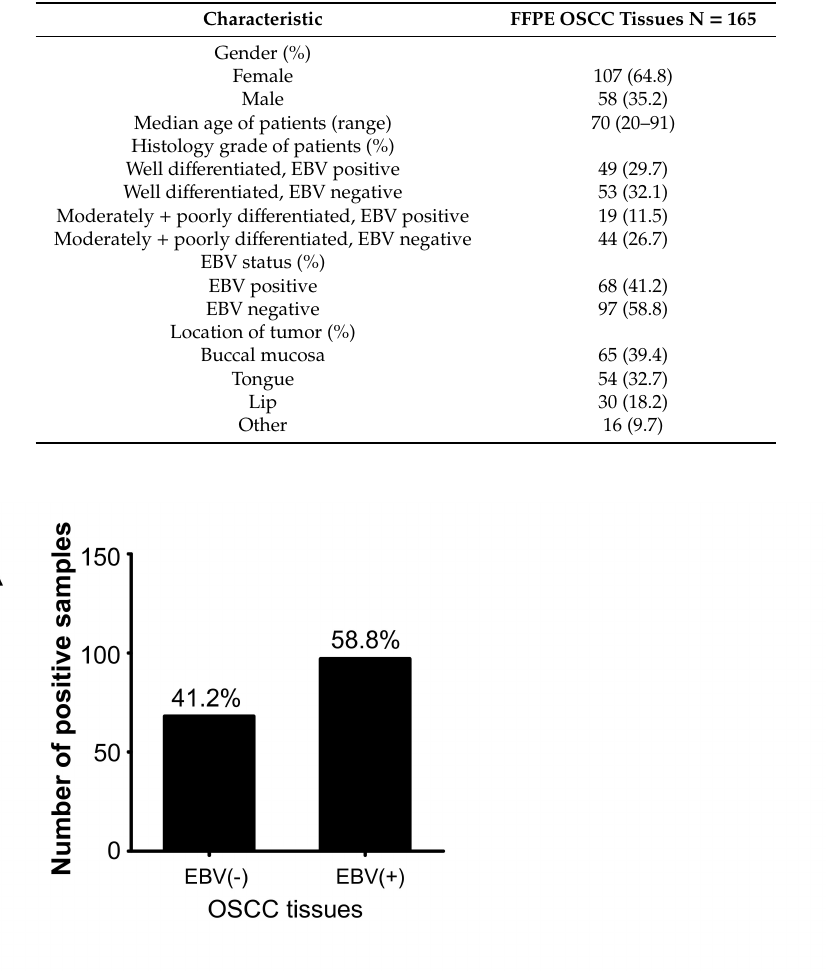
Table2. Demographicdataoforalsquamouscellcarcinoma(OSCC)patientswhoprovidedarchivedsamples.